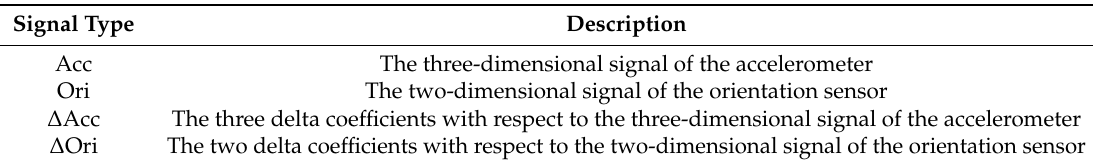
Table 1. Four signals derived from the built-in smartwatch